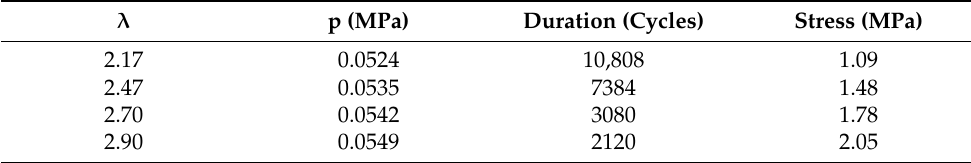
Table 2. Results of the experimental tests and numerical stress values.